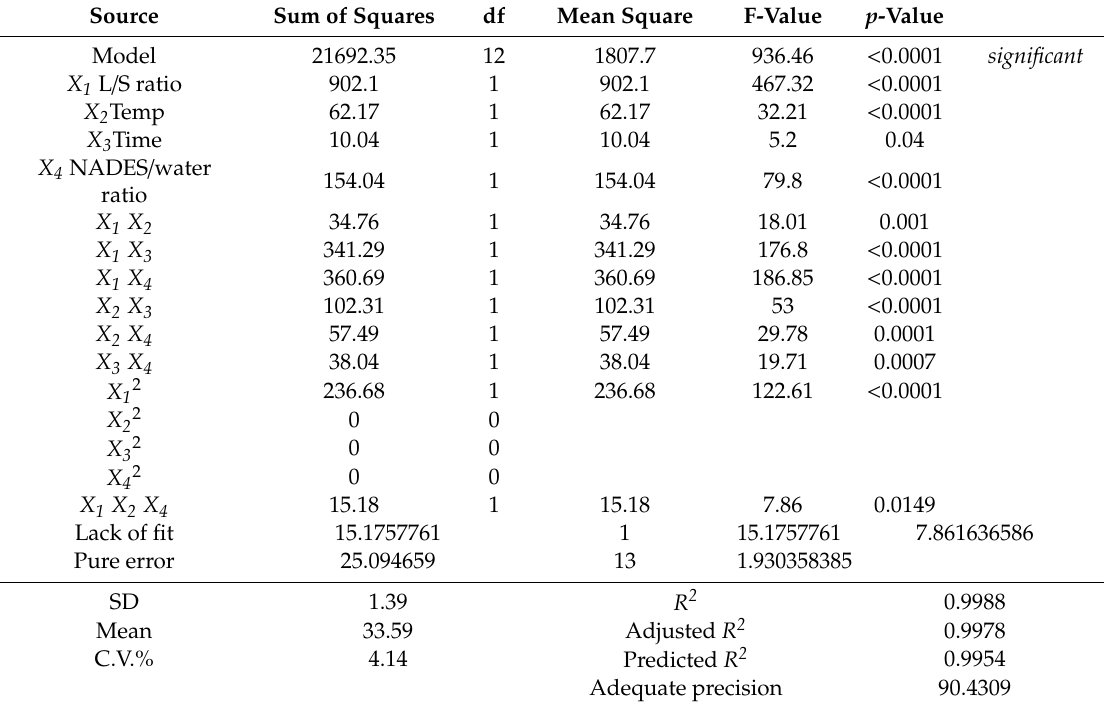
Table 4. Analysis of variance (ANOVA) for DSD for pectin yield using ChCl–Mal and its fit statistics. Source Sum of Squares df Mean Square